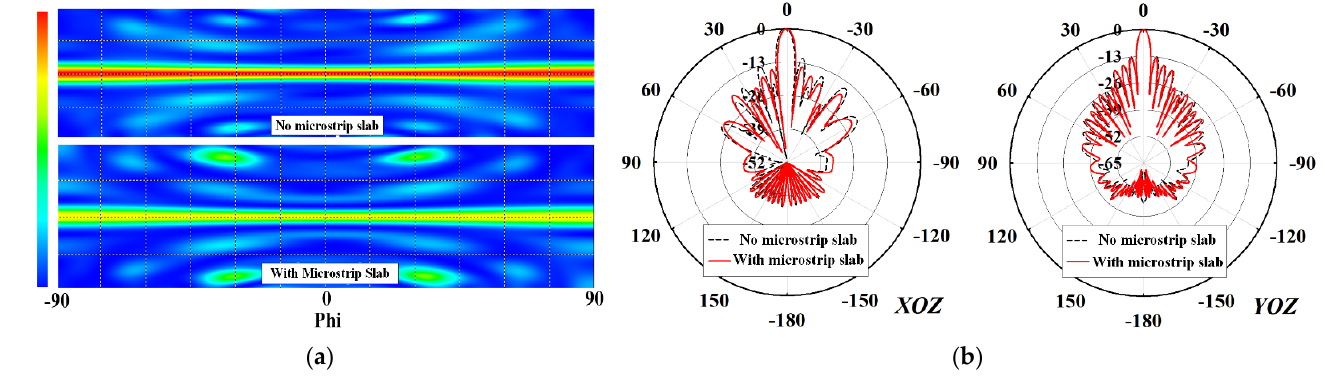
Figure 8. ( a ) Simulated radiation amplitude of the feeding network at 9.65 GHz and ( b ) 2D simulated radiation patterns of the proposed 12 × 16 array antenna with and without the suspended microstrip slab structure at 9.65 GHz.